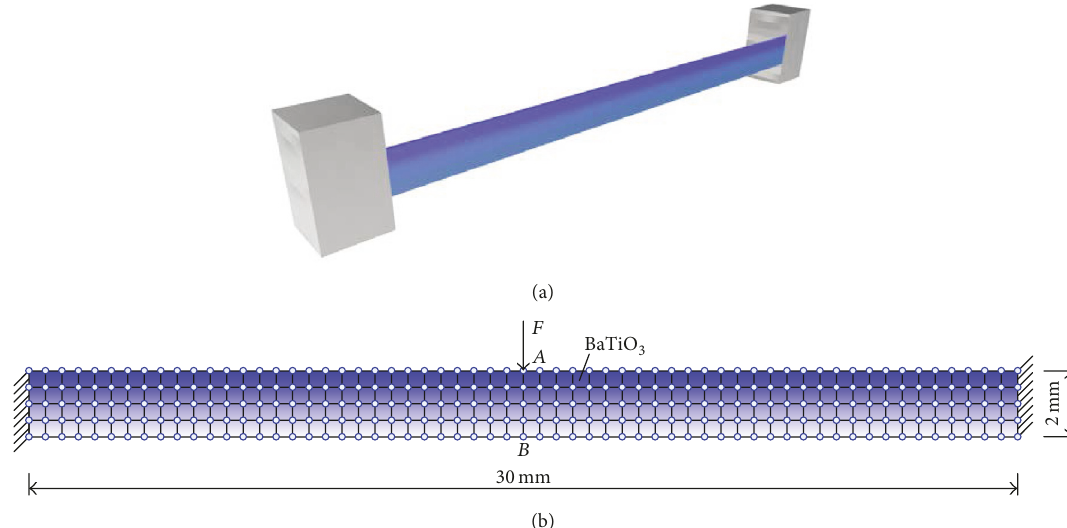
Figure 13: Typical MEMS-based energy harvester fabricated with BaTiO 3 FGMEE. (a) Model of the energy harvester; (b) simplified model of